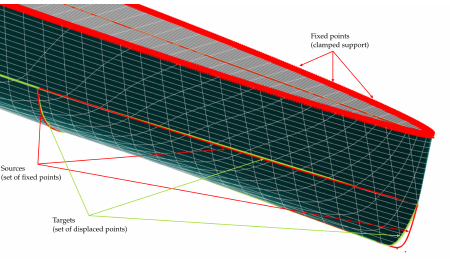
Figure 7. Fixed point (clamped support and sources) and displaced points (targets) for the forebody of the